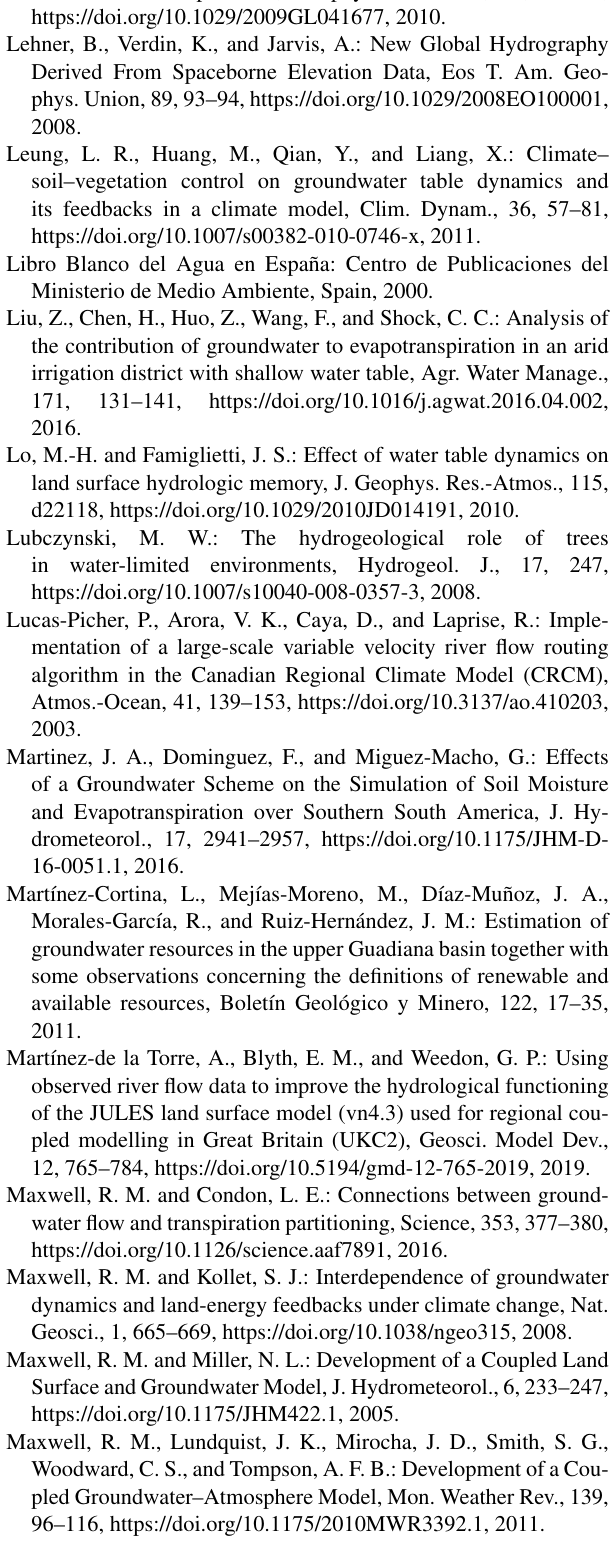
ter table simulations, J. Geophys. Res.-Atmos., 112,